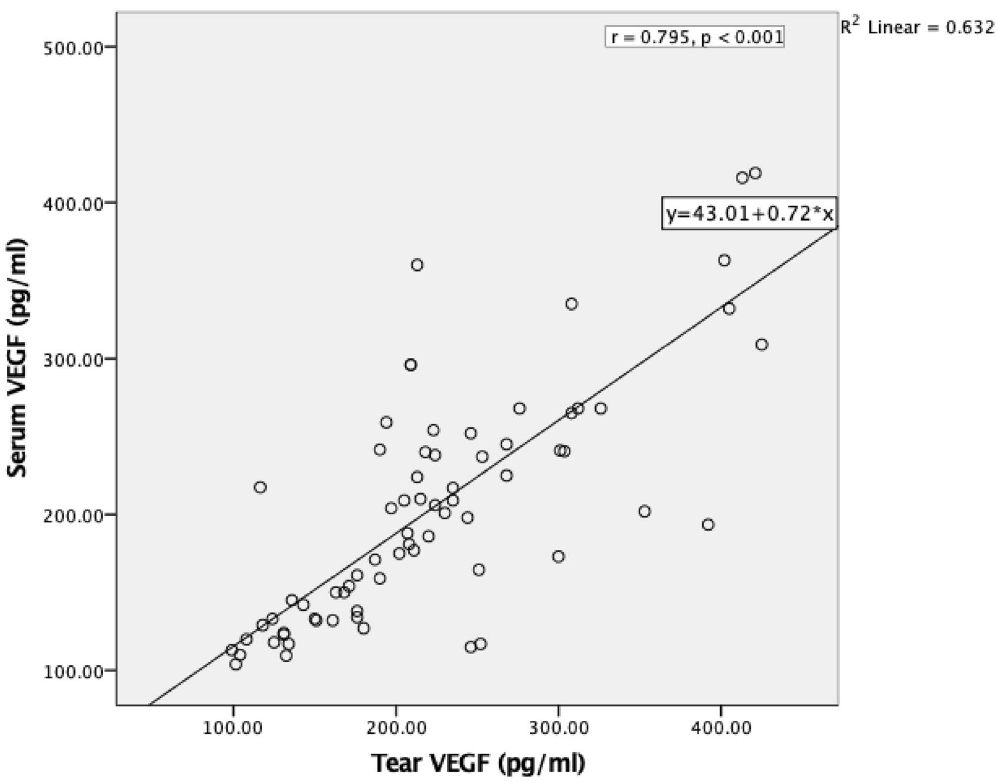
Figure 2. Pearson correlation analysis shows that the tear VEGF level in AMD patients was positively correlated to the serum level ( r = 0.795, p <